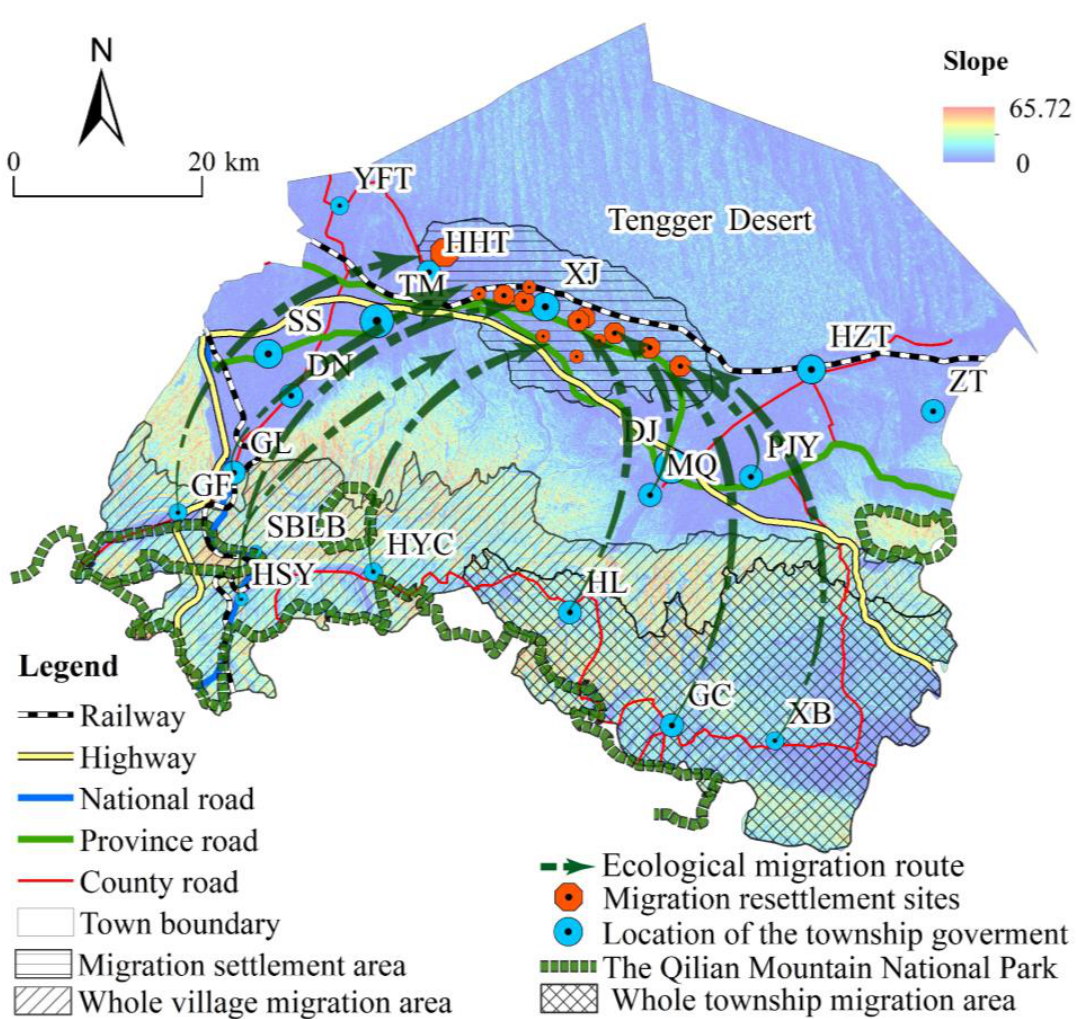
Figure 3. Diagram of the spatial migration route for ecological migrants.